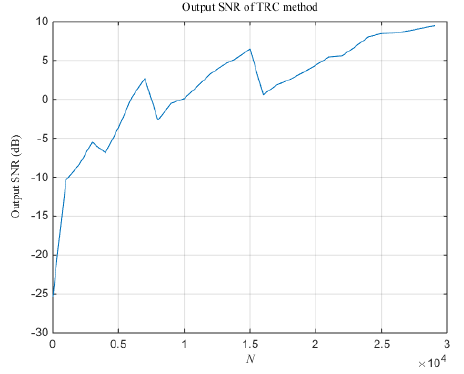
Figure 6. The change curve of the output SNR of the TRC method following N.